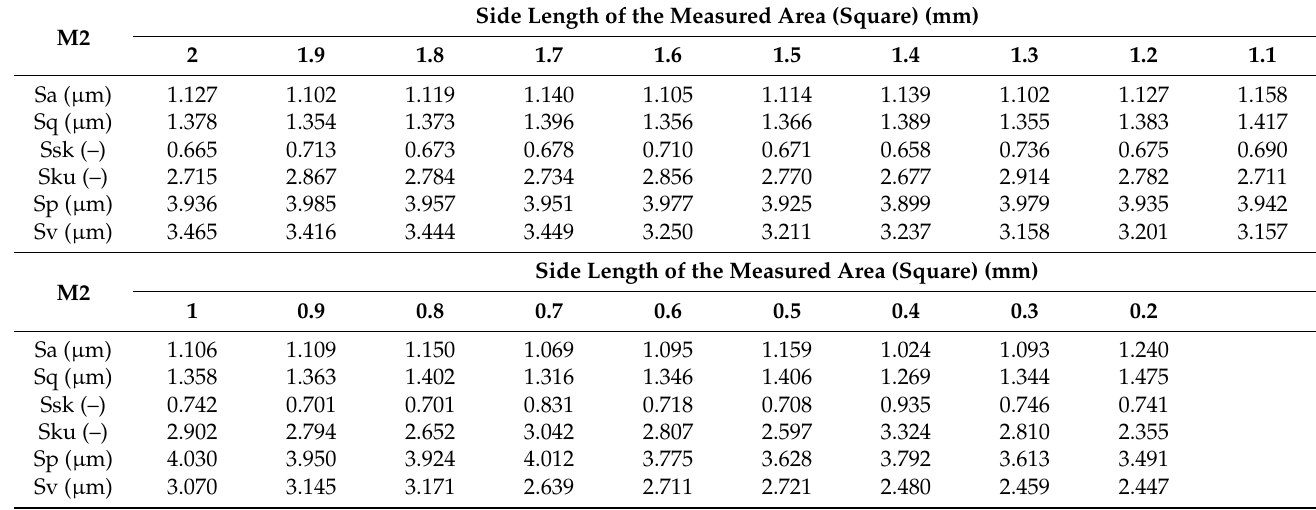
Table A3. Surface roughness values for the procedure version